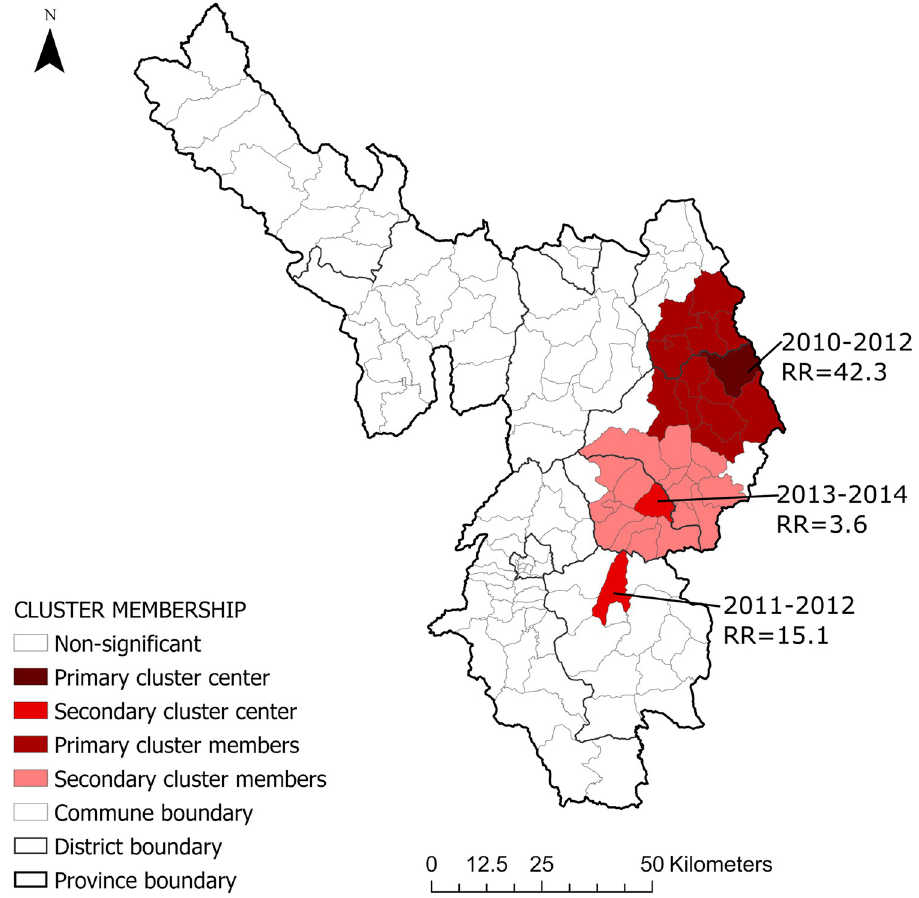
Fig 3. SaTScan-defined space-time clusters and relative risk of human anthrax (Poisson model, 999 permutations, 25% population at risk) in Dien Bien province, Vietnam. The space-time scan statistics were performed 15%, 25%, and 50% population at risk. Although the variation in the size of clusters were seen at different sizes of circles, the clusters persisted in the same areas in short periods, therefore, the results at 25% were reported (detail in S7 Fig. Maps produced in ArcGIS Pro using political boundary shapefiles from https://geodata.ucdavis.edu/gadm/gadm4.1/shp/